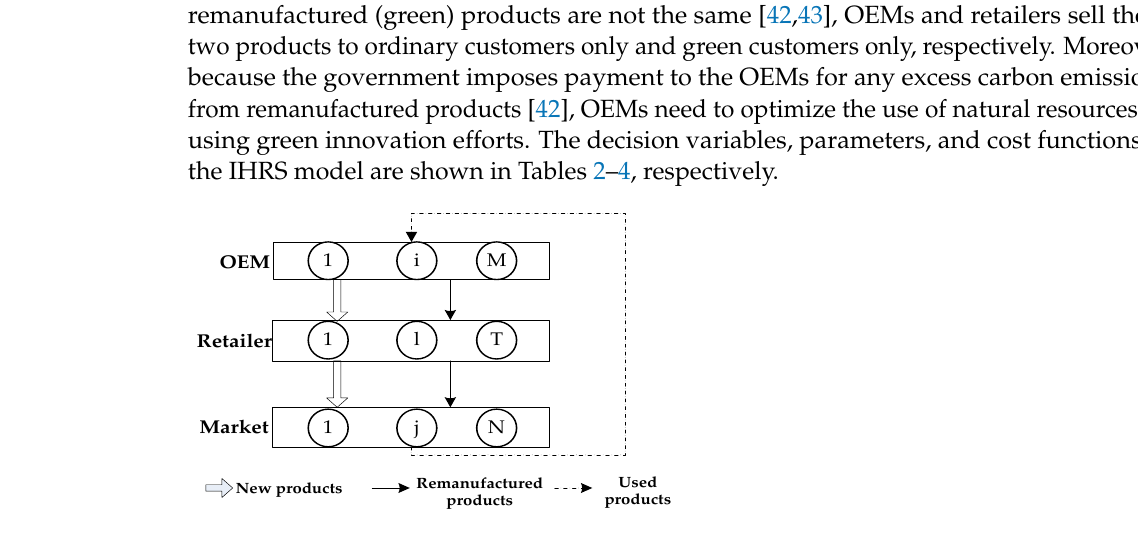
Figure 1. The CLSC network of the IHRS model. Table 2. The decision variables in the IHRS model.